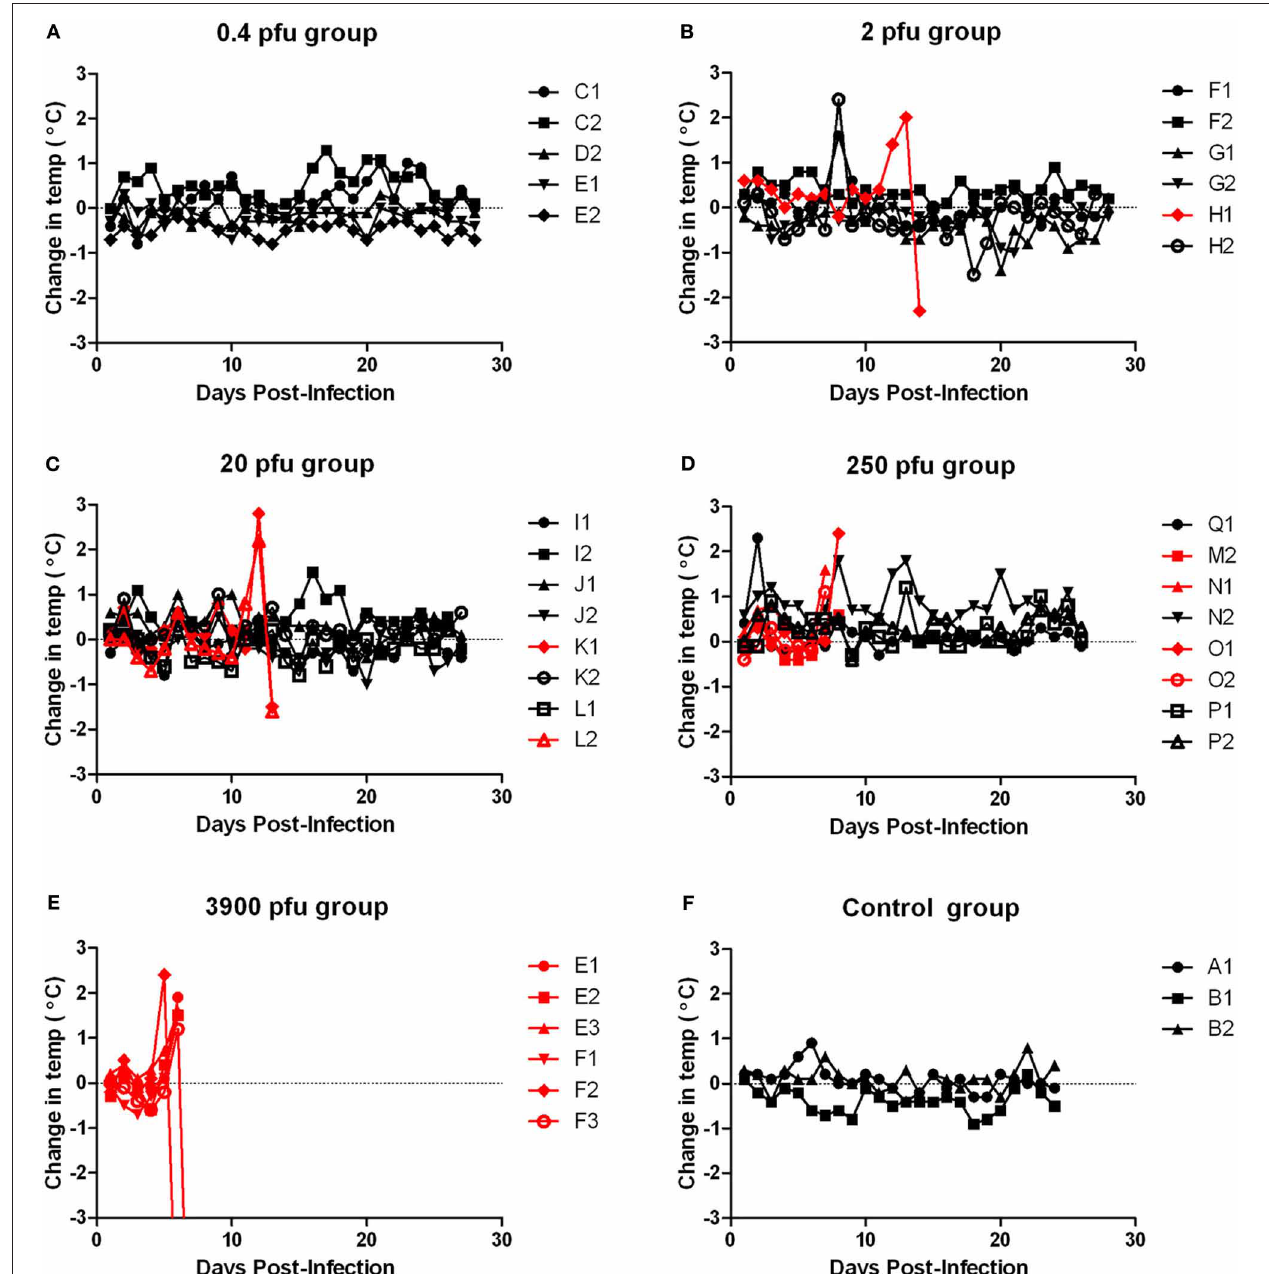
FIGURE 6 | Body temperature of ACI rats infected with aerosolized RVFV. Groups of six to eight female ACI rats were infected with RVFV by the aerosol route at five doses plus uninfected controls. (A) 0.4pfu/rat; (B) 2pfu/rat; (C) 20pfu/rat; (D) 250pfu/rat; (E) 3900pfu/rat; (F) Uninfected